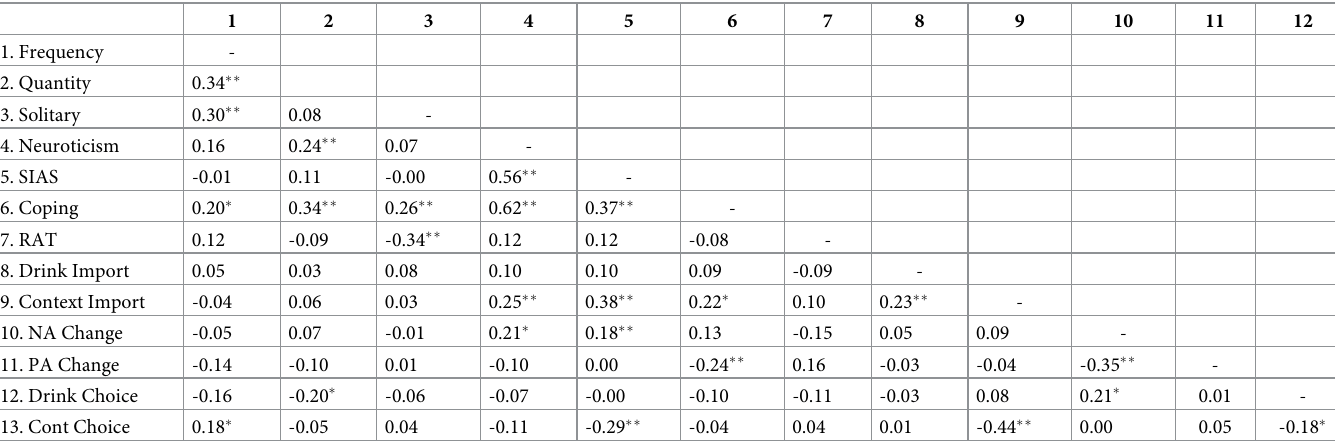
Table 2. Bivariate correlations between variables of interest.